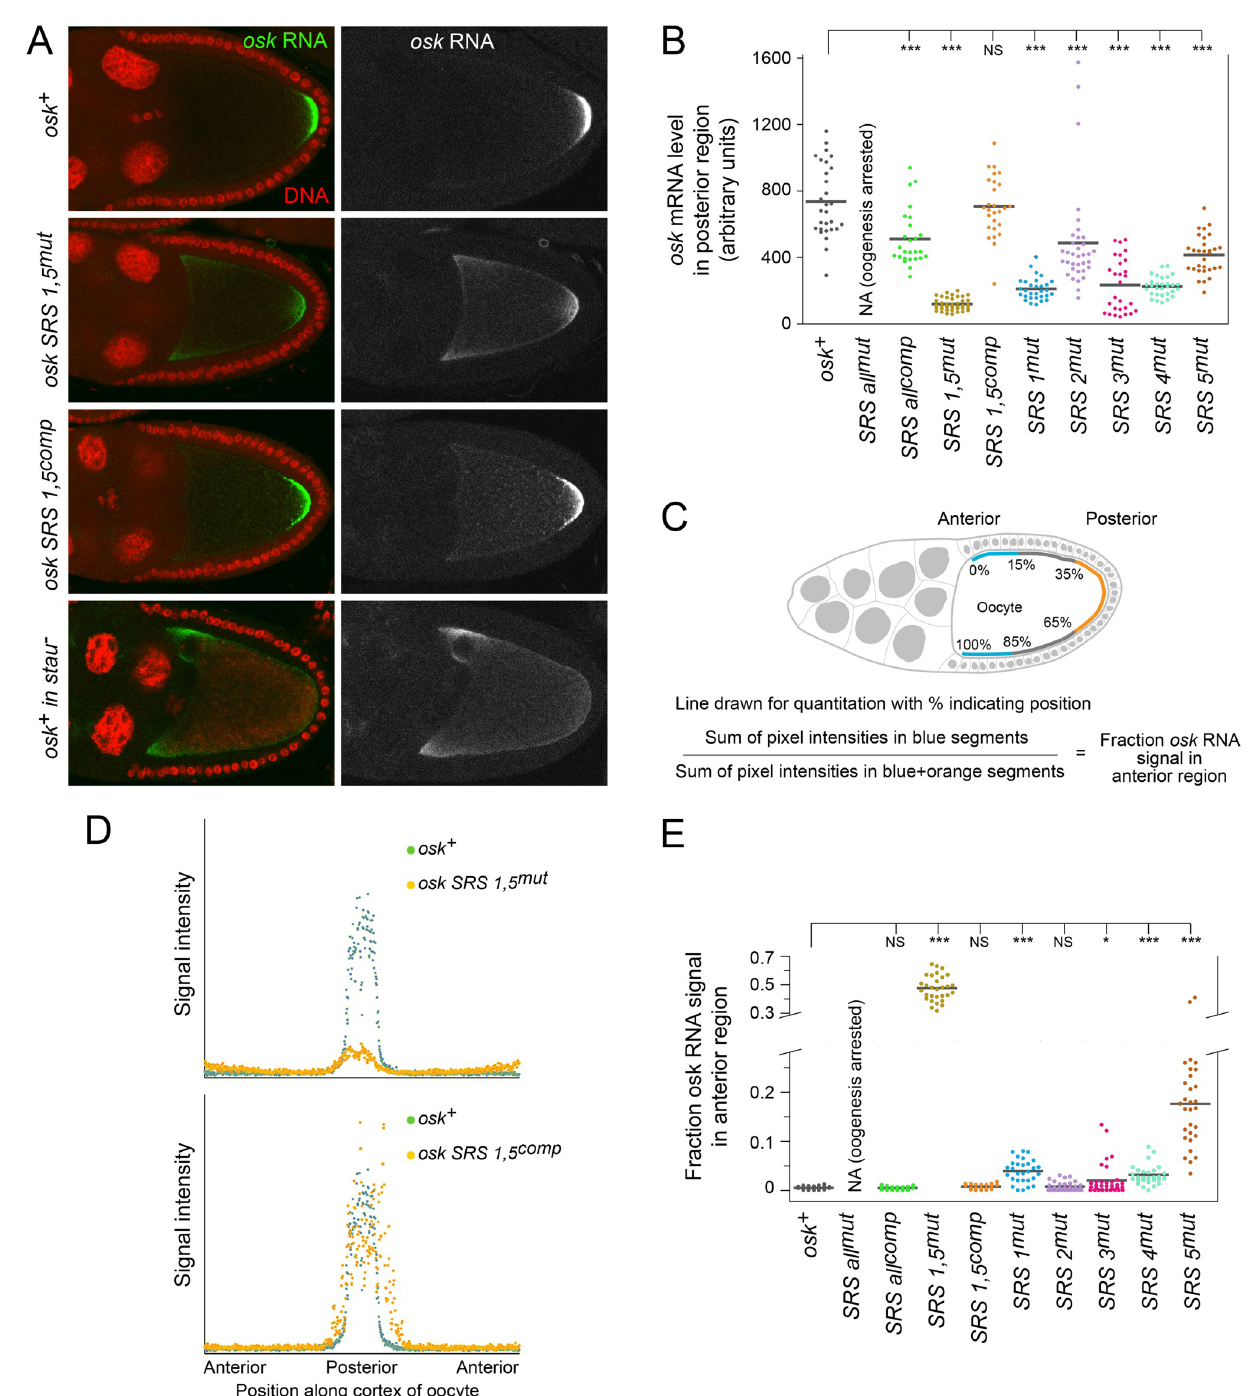
Fig 6. Characterization of genomic osk transgenes carrying SRS mutations. (A) Distribution of osk mRNAs in late stage 9 egg chambers. For the right panels, only the RNA channel is shown (white). The bottom panels are not directly comparable for signal intensity (2 copies of endogenous osk for the bottom panel vs 1 copy of osk transgenes for the upper three panels, and different imaging sessions) but can be compared for mRNA distributions. (B) Posterior localization of osk mRNAs. Values are for total signal intensity within the posterior region of localization, not solely at the cortex as in panel D. Results are presented in dot plot format. N values for all genotypes were 26 or greater. Statistical significance was evaluated by one-way ANOVA with F (8,264) = 53.52, P < 6 x 10 − 51 . Normality was rejected (Bonferroni corrected Shapiro-Wilk test), therefore the Wilcoxon rank sum test was used for post hoc analysis. ��� : P < 0.01, NS: not significant. (C) Method for quantitation of fraction of osk mRNA signal in anterior region. Signal intensities were measured at multiple points in lines traced along the cortex, starting at the anterior edge, through the posterior, and back to the anterior edge on the other